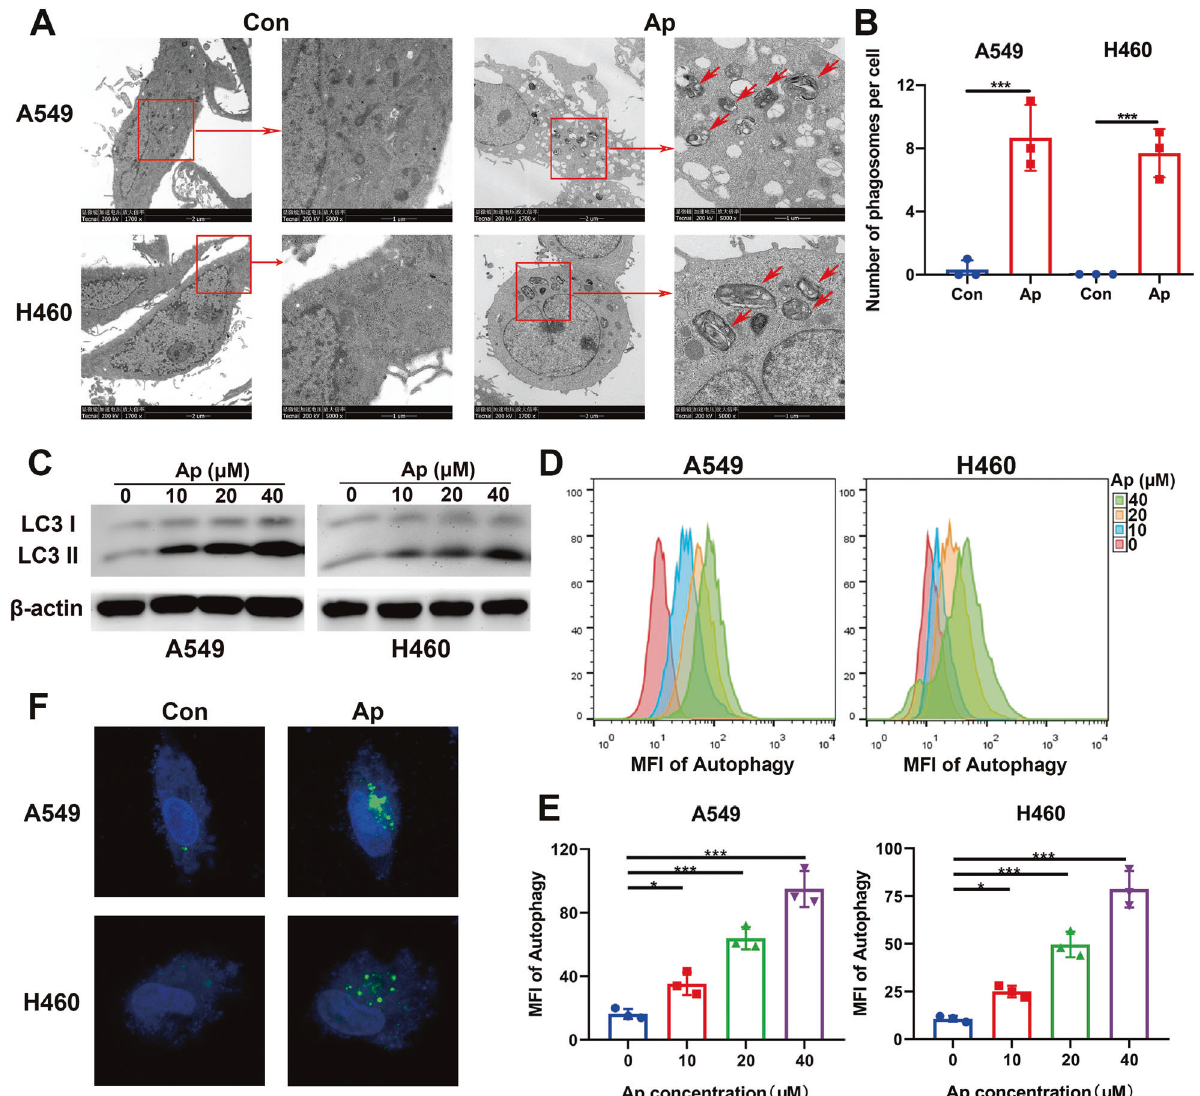
Fig. 2 Apatinib induced autophagy in NSCLC cells. A , B Representative TEM images and analysis of the number of autophagosomes/ autolysosomes of A549 and H460 cells with apatinib (20 μ M, 48 h) or negative control incubation. Short red arrows: autophaosomes or autolysosomes. C LC3 I/II expression was detected by WB in A549 and H460 cells after treatment with incremental concentrations of apatinib for 48 h. D , E Cyto-ID detection assay measured the autophagy levels of A549 and H460 cells after treatment with incremental concentrations of apatinib for 48 h. F Representative images obtained by confocal microscopy of GFP-LC3 expression in A549 and H460 cells with apatinib (20 μ M, 48 h) or negative control treatment. Data are presented as mean ± SEM from three independent